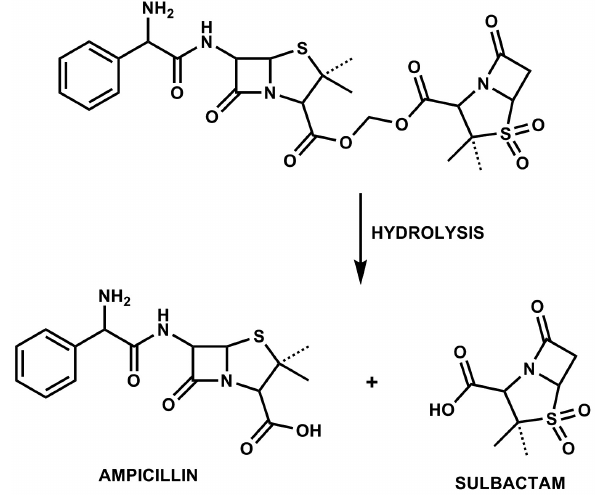
FIGURE 33 - Diagram of bioactivation of the sultamiciline